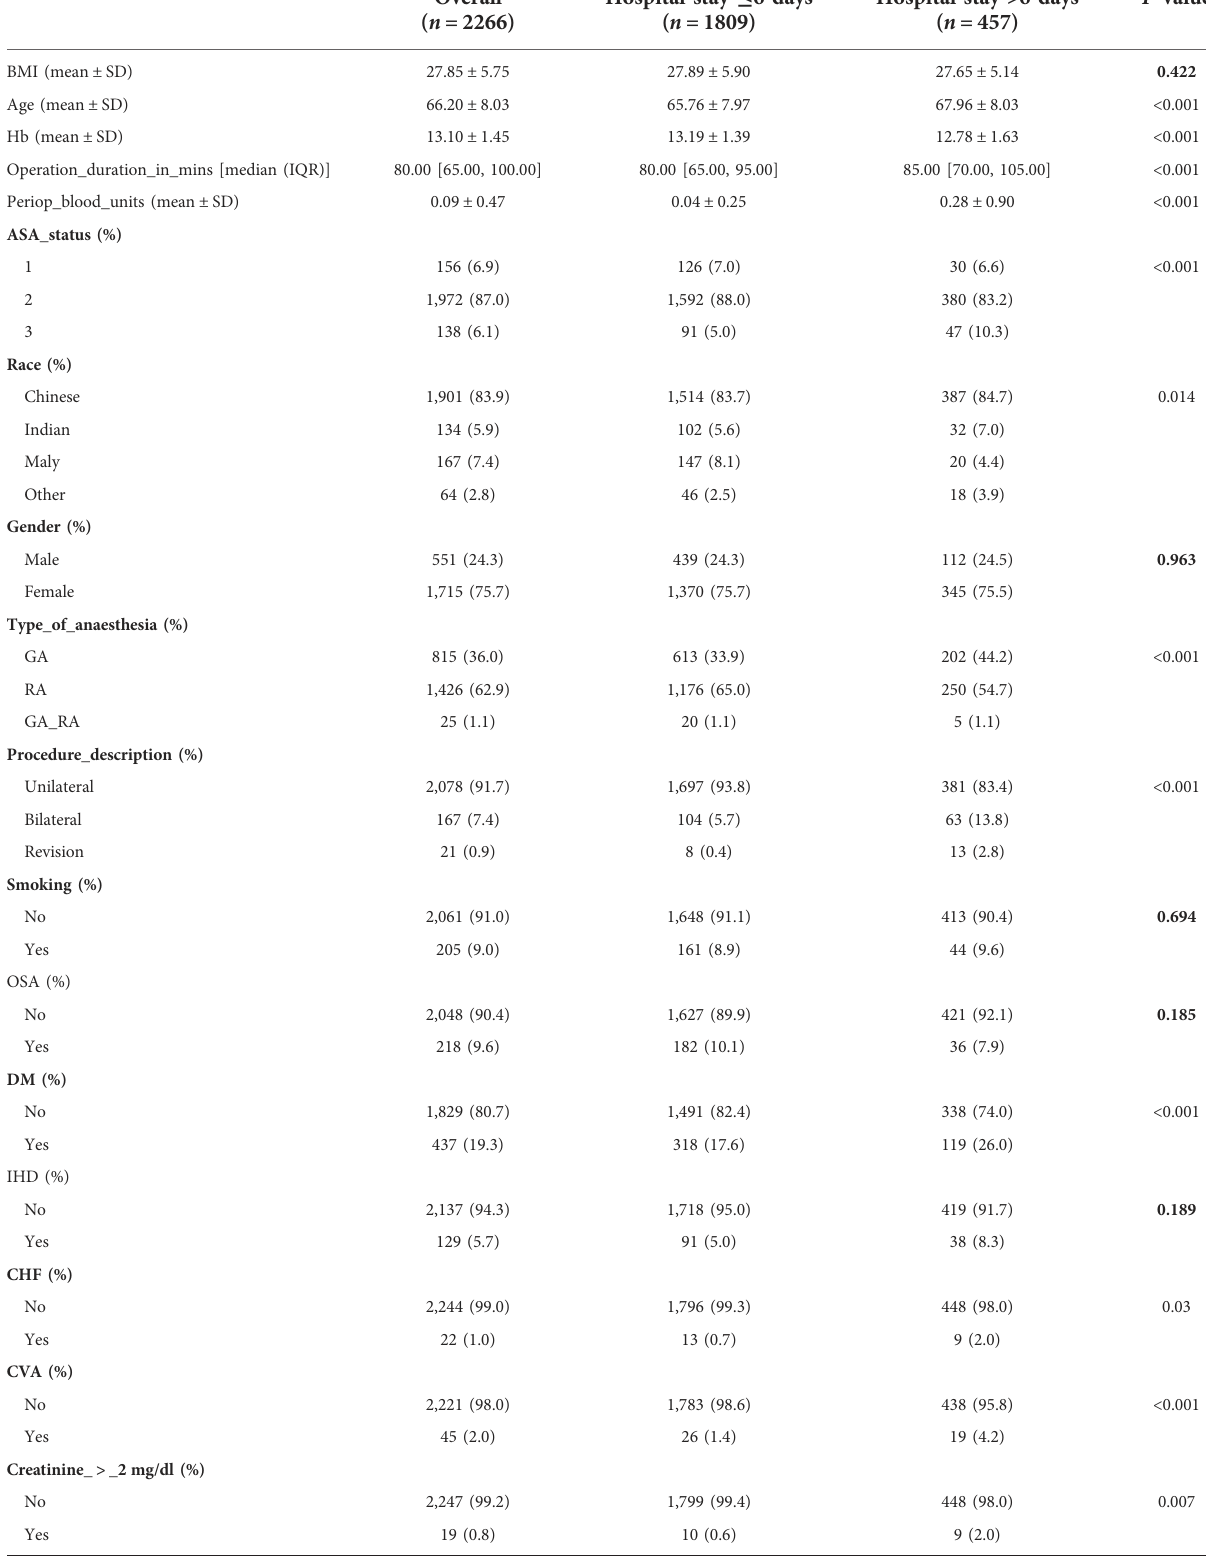
TABLE 1 The demographic characteristics of